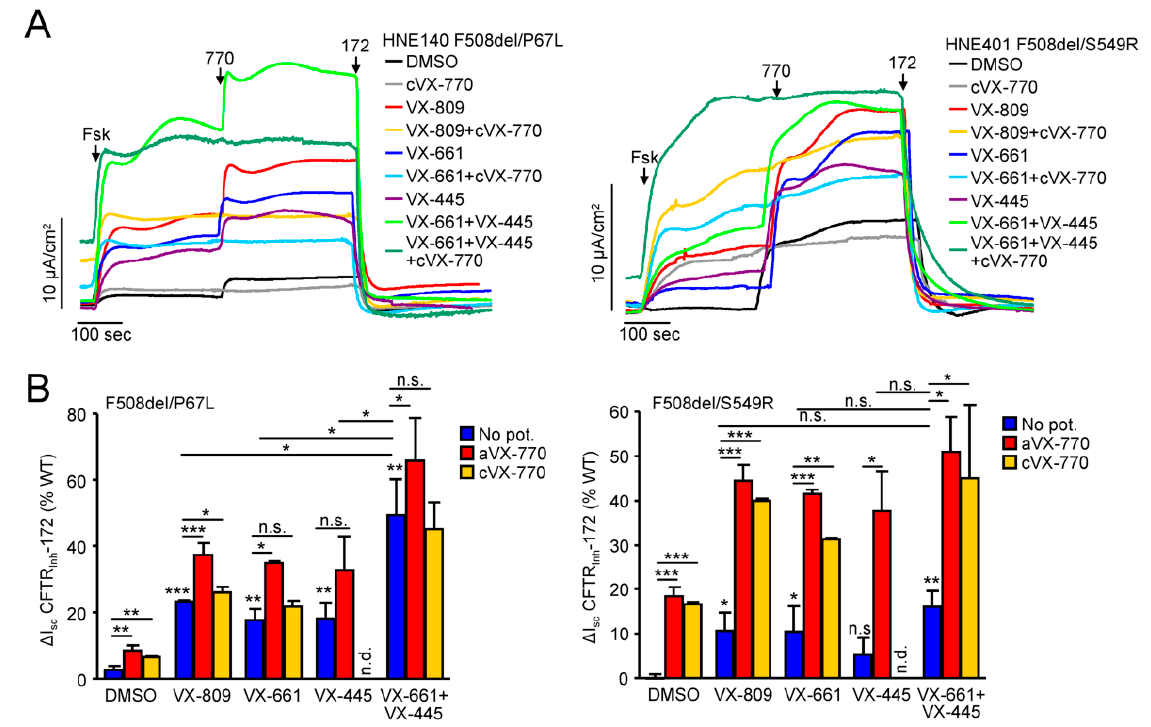
Figure 5. Efficacy of CFTR modulators for the functional correction of P67L- or S549R-CFTR in HNE. ( A , B ) Effect of indicated single correctors or corrector combinations (VX-809, VX-661-3 µ M; VX-445, 2 µ M; 24 h) alone (no pot.) or in combination with acute VX-770 (aVX-770) or chronic VX-770 (cVX-770-1 µ M, 24 h) potentiation on the I sc of HNE with a F508del/P67L (left panels) or F508del/S549R (right panels) genotype. Representative traces ( A ) and quantification of the CFTR Inh -172 inhibited current expressed as percentage of WT-CFTR currents in HNE from 10 donors ( B ). Data in B are means ± SD of 3 measurements. n.s.—not significant, * p < 0.05, ** p < 0.01, *** p < 0.001 by Student’s t